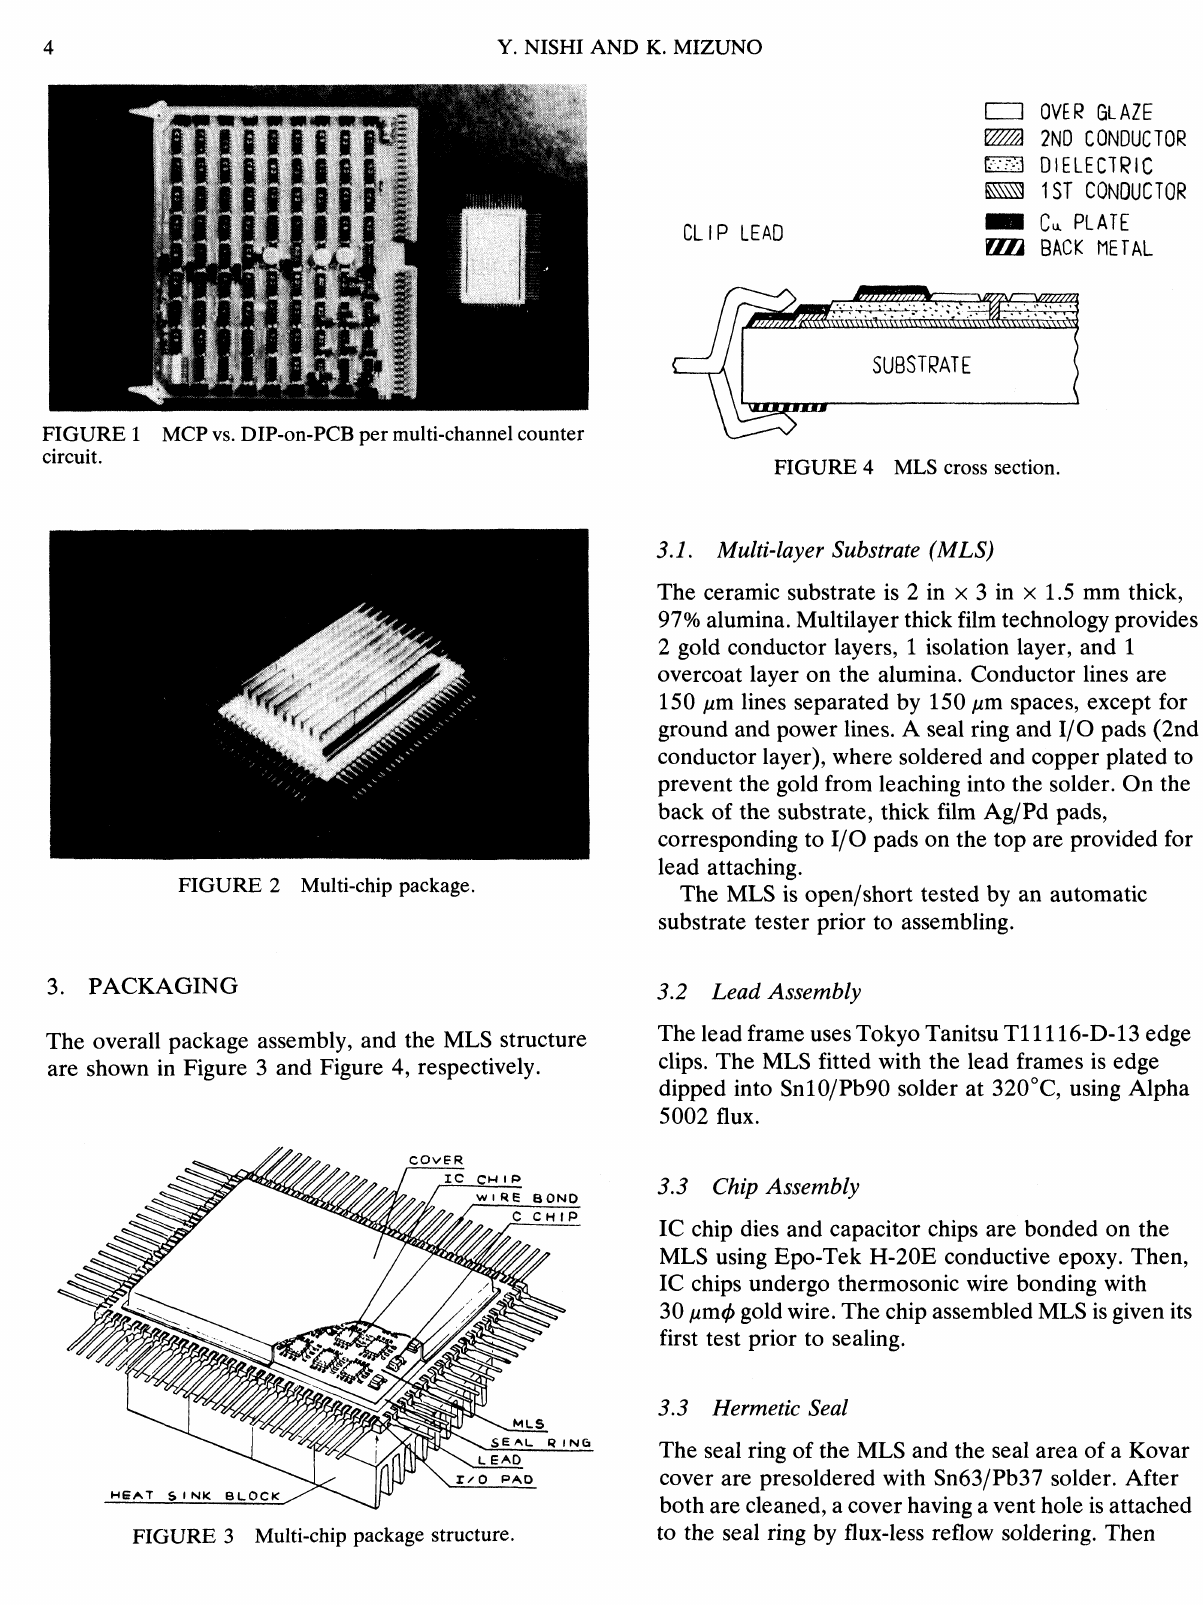
FIGURE 3 Multi-chip package